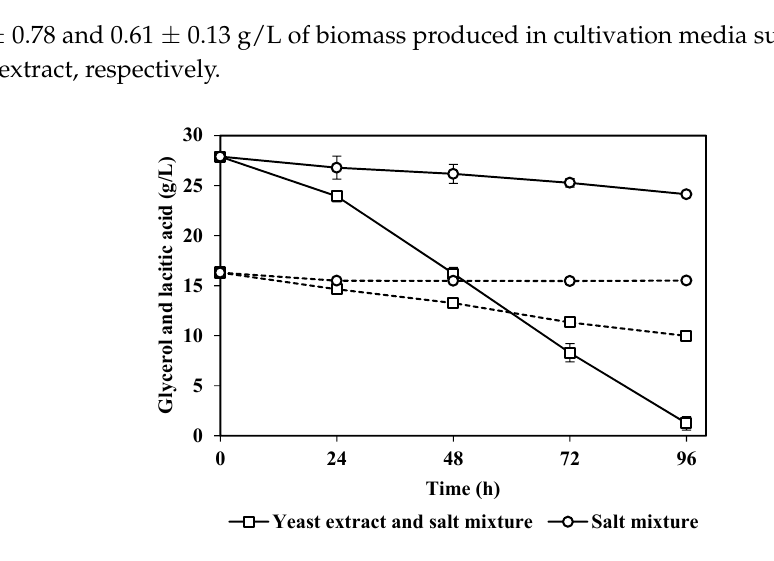
Figure 5. Utilization of lactic acid (dashed line) and glycerol (solid line) by A. oryzae in mediums supplemented with salt mixture ( ○ ) or salt and yeast extract ( □ ).